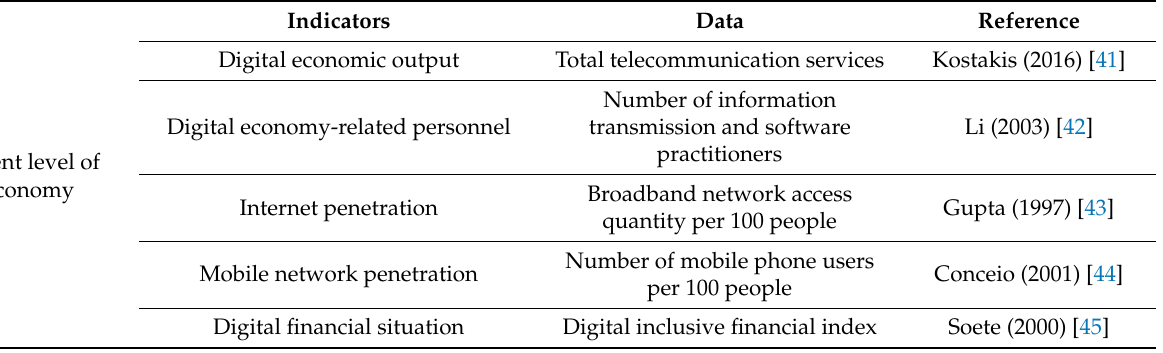
Table 1. Measurement indicators of social digital economy development level.